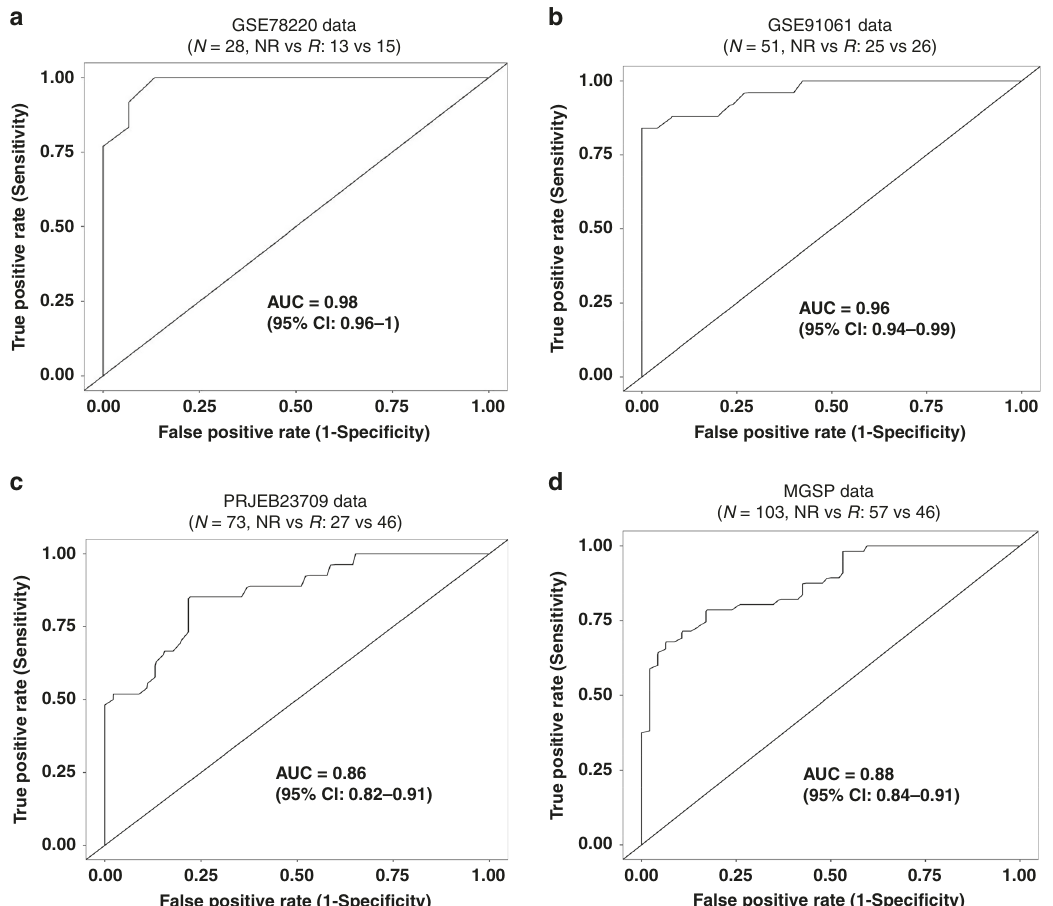
Fig. 4 The ImmuneCells.Sig signature may predict ICT outcome in melanoma patients. a ImmuneCells.Sig had signi fi cantly high prognostic values for ICT outcomes in the initial discovery dataset - GSE78220. b ImmuneCells.Sig accurately predicted the ICT outcome in the fi rst validation dataset of GSE91061. c ImmuneCells.Sig accurately predicted the ICT outcome in the second validation dataset of PRJEB23709. d ImmuneCells.Sig accurately predicted the ICT outcome in the third validation dataset of